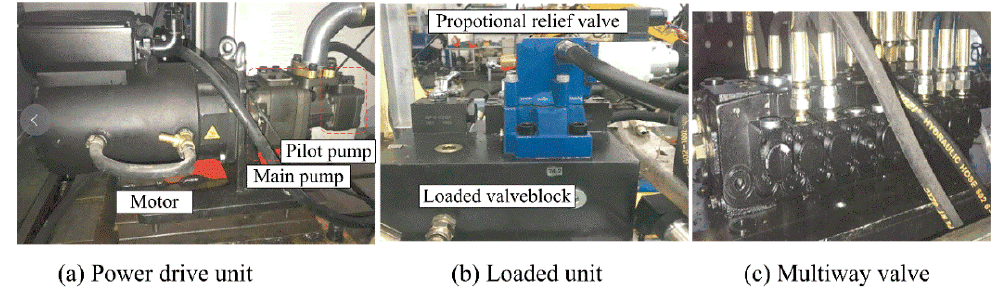
Figure 13. Key components of the test rig.